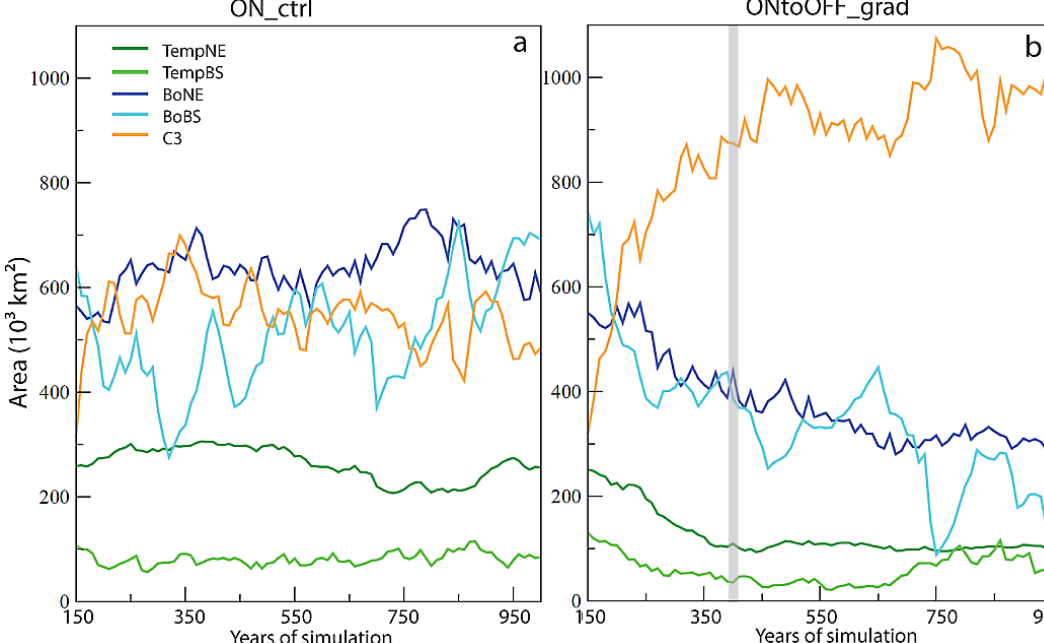
Fig. 10. Temporal evolution of the area occupied by each PFT over Western Europe (lat=32/60 ◦ , lon= − 15/20 ◦ ) in (a) ON ctrl and (b) ONtoOFF grad (10 3 km 2 , values are averages over 10yr of run). The vertical grey bar indicates the full AMOC collapse. PFT acronyms: see Table 1. The area of TempBE remains below 20 × 10 3 km 2 and this PFT has been omitted on both